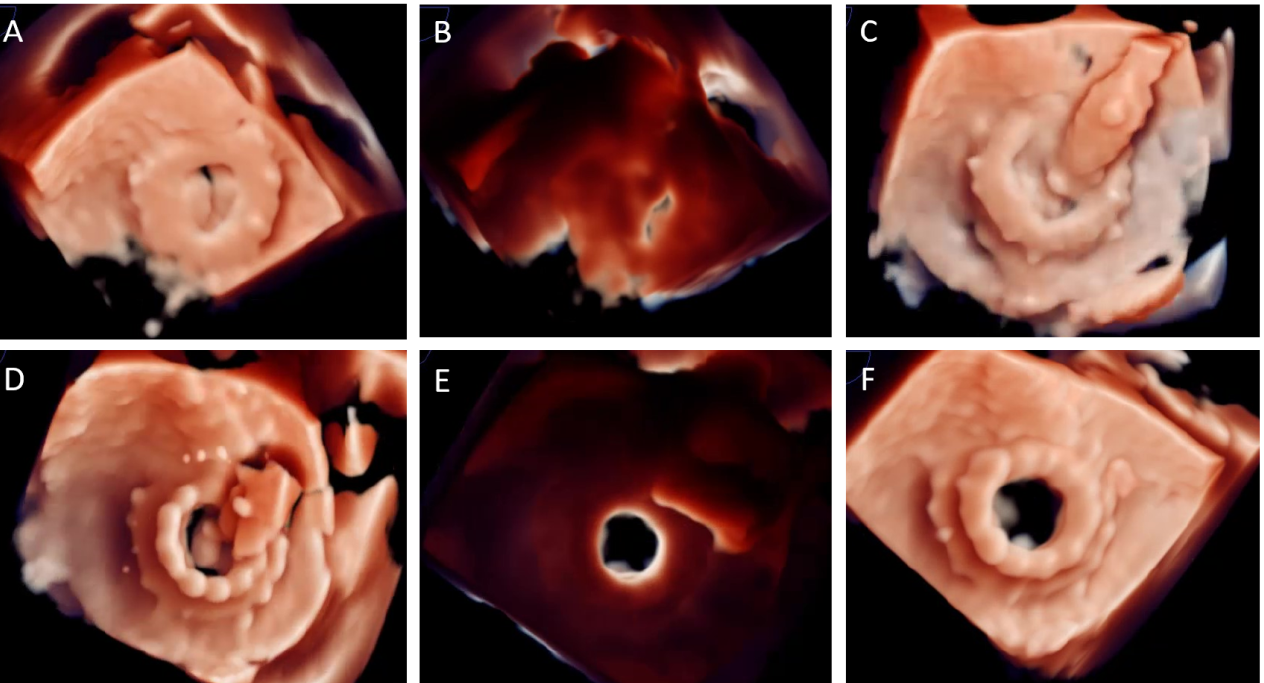
Figure 3. Three-dimensional transoesophageal echocardiography with photo-realistic rendering during TMVR valve-in- valve procedure. ( A ) En-face view of a degenerated mitral surgical prosthetic valve, with severe prosthetic stenosis. ( B ) Same image with light source place behind mitral prosthetic valve during diastole. Prosthetic leaflets thickening and mobility reduction can be easily noted. ( C ) THV positioning inside SHV. ( D ) Balloon-expandable THV deployment. ( E ) Immediate result after deployment. Same image configuration than ( B ), significant improvement in diastolic opening can be noted. ( F ) TMVR ViV final result en-face view.